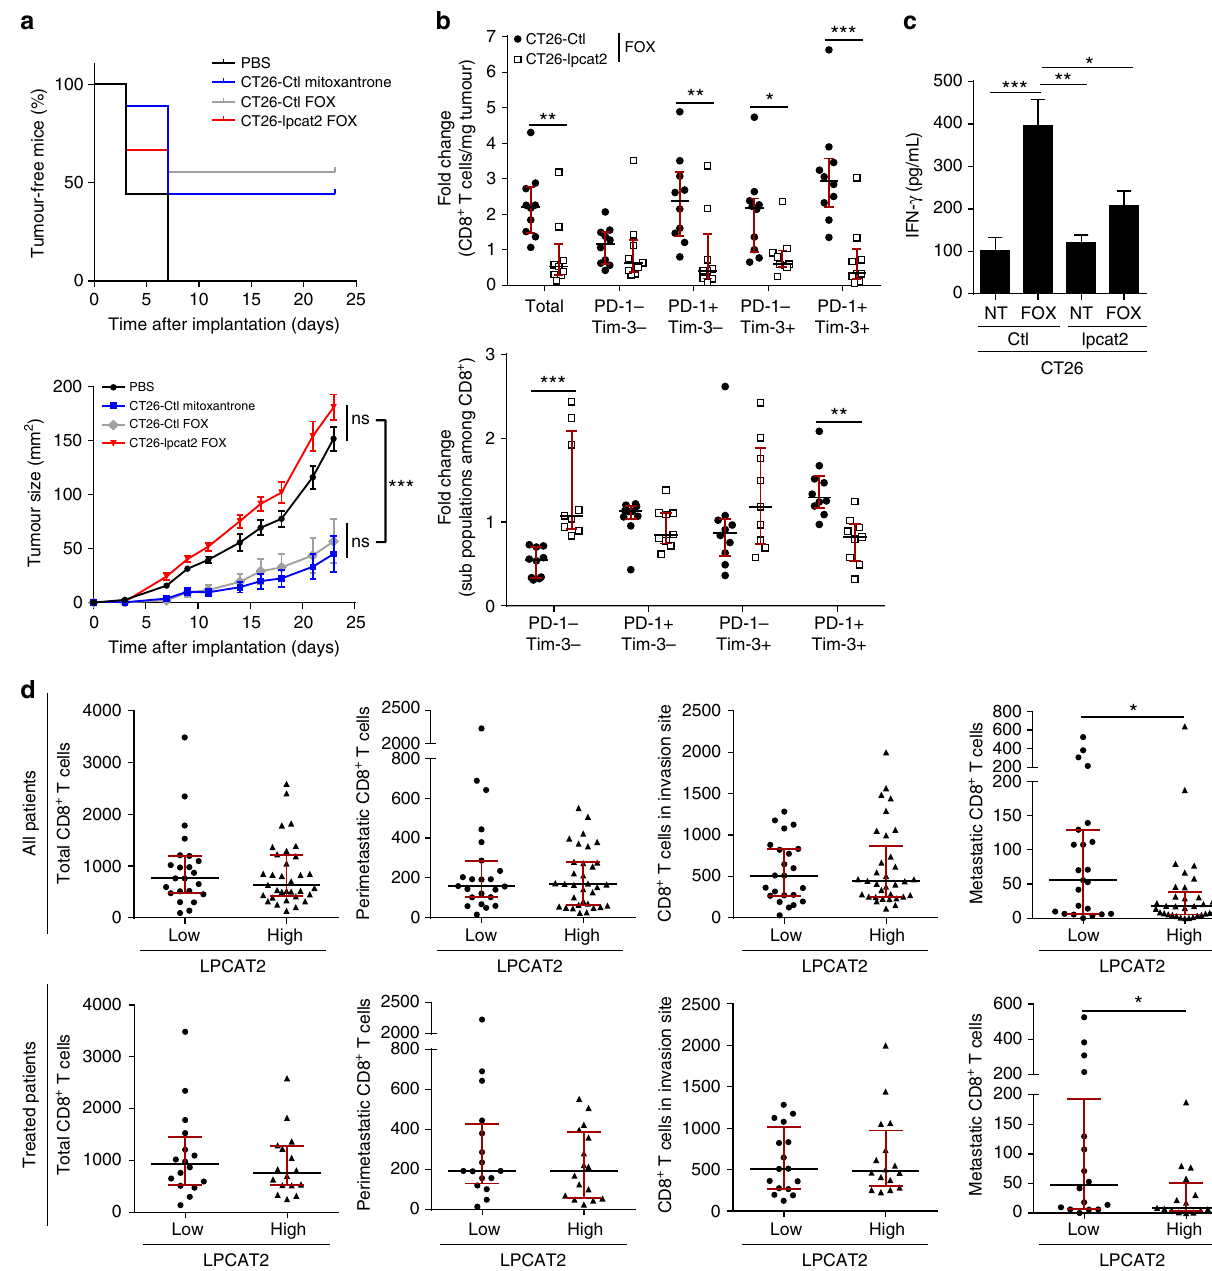
Fig. 9 LPCAT2-induced LD accumulation prevents ICD. a Vaccination experiments: upper panel, percentage over time of tumour-free mice for each group. Lower panel, growth curves over time of setting tumours ( n = 9 of 8-week-old female balb/c mice per group). Values are mean ± s.e.m. P values were determined by two-way ANOVA with Bonferroni correction. * p < 0.05, ** p < 0.01, *** p < 0.001. b CT26-lpcat2 ( n = 20) and CT26-Ctl ( n = 20) tumour-bearing 8-week-old female balb/c mice were subdivided into two groups ( n = 10 per group) and intraperitoneally injected with vehicle or FOX. Tumour grafts were immunostained for CD3 + CD8 + T-cell-subtype identi fi cation and PD-1 and Tim-3 subpopulation phenotyping. Fold change of the number of CD8 + T cells and percentage of sub-populations among CD8 + cells were calculated for each condition according to their respective untreated group. P values were determined by the multiple Student t test. * p < 0.05, ** p < 0.01, *** p < 0.001. The data represent medians with interquartile ranges. c Supernatants of dissociated tumours described in b ) were assayed by ELISA for IFN- γ secretion. P values were determined by two-way ANOVA with Bonferroni correction. * p < 0.05, ** p < 0.01, *** p < 0.001. Error bars denote s.e.m. d Histological LPCAT2 and CD8 immunostainings performed on hepatic metastasis samples from 56 CRC patients. Absolute quanti fi cation of CD8 + T cells in the metastatic, peri-metastatic, invasion and total site was performed and compared between groups with low and high-LPCAT2 expression/scoring. Comparisons were made for all CRC patients ( n = 56) and for patients who received neoadjuvant chemotherapy ( n = 32). P values were determined by Mann – Whitney U test. * p <